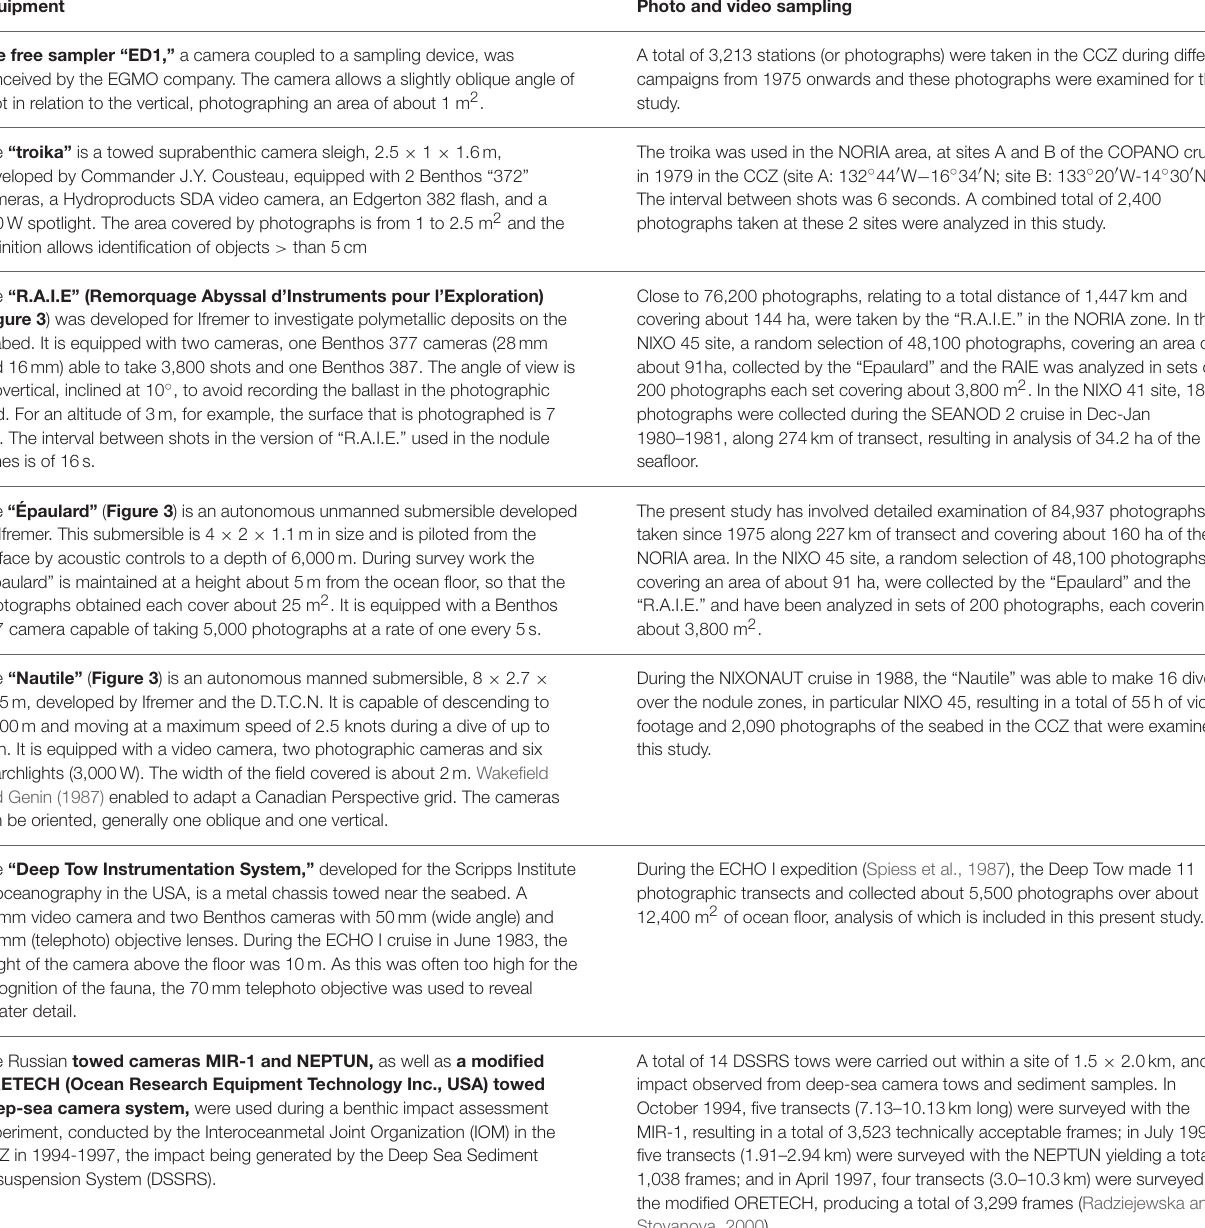
TABLE 2 | Details of the different observation platforms and methodologies used on the study sites, together with information on the lengths of transects and numbers of images captured.